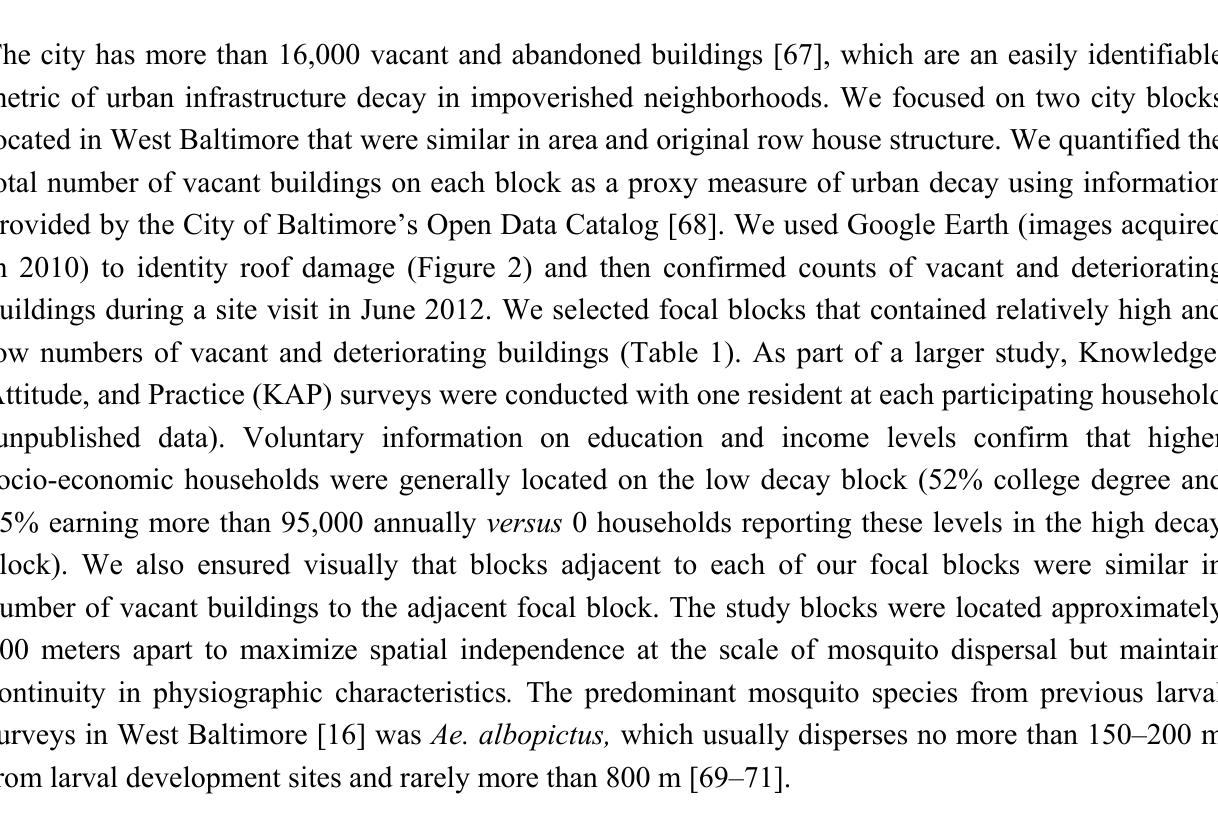
Figure 2. Aerial photos circa 2010 of the study blocks (Google Earth) with low (top) and high (bottom) urban decay symptoms. Red and blue boxes indicate vacant buildings with damaged or intact roofs, respectively. Stars represent adult trap sites and red arrows indicate mosquito positive larval